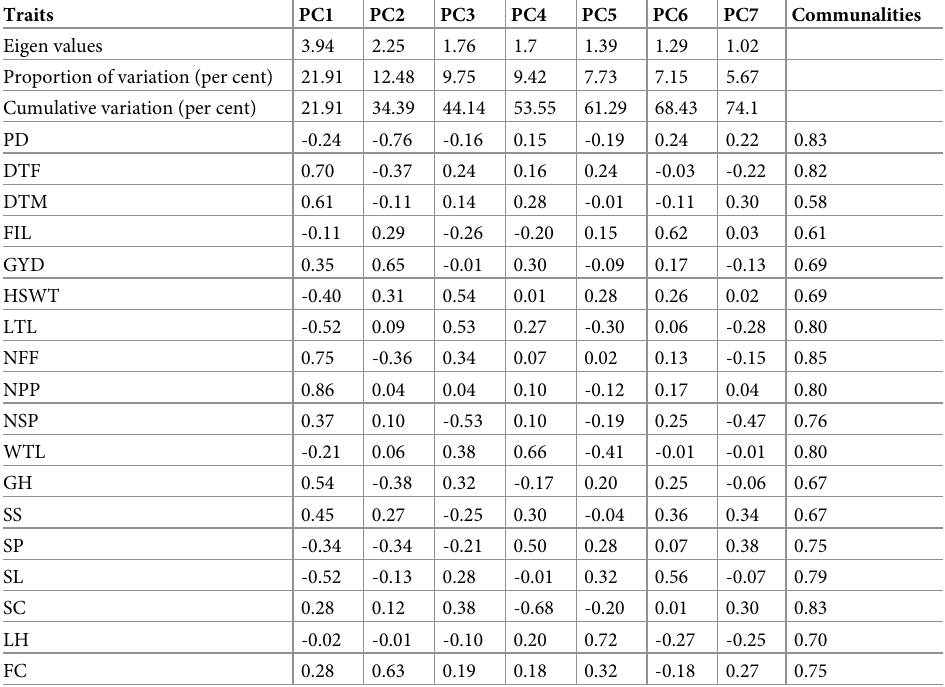
Table 6. Eigen-values, proportion of variability and loading scores for the first seven PCs among 60 common bean genotypes evaluated in two years. Traits